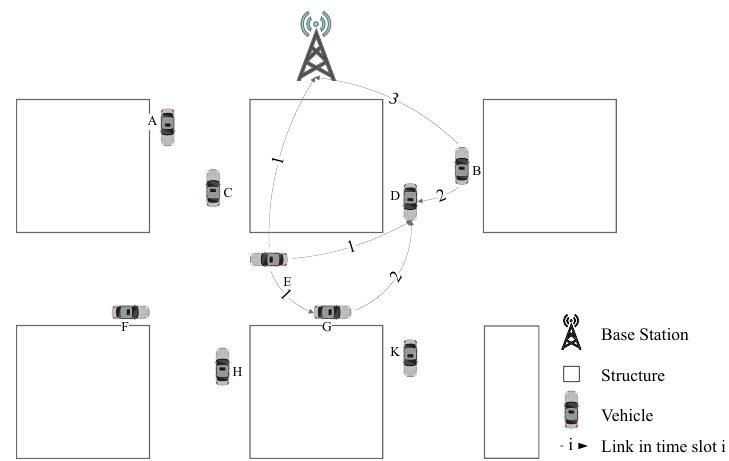
Figure 6. Example of V2I without Assisted Transmission.